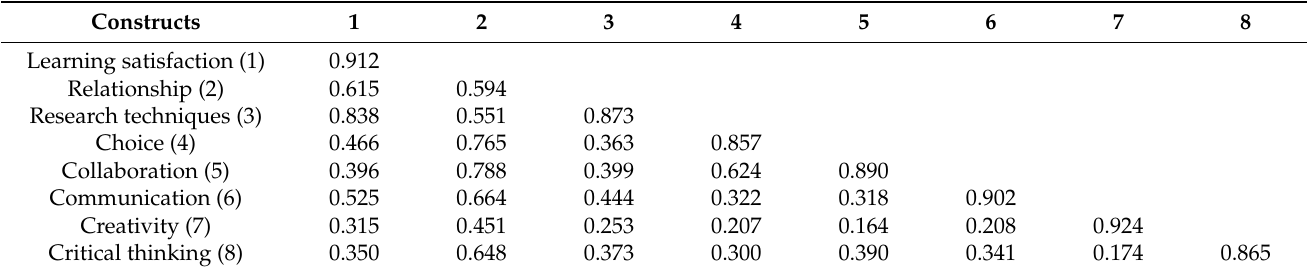
Table 3. Fornell-Larcker Criterion.